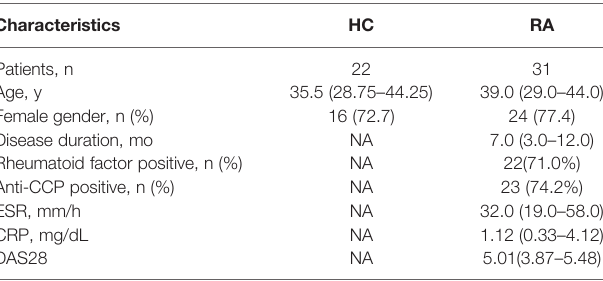
TABLE 1 | Basic characteristics of HC and RA patients*.